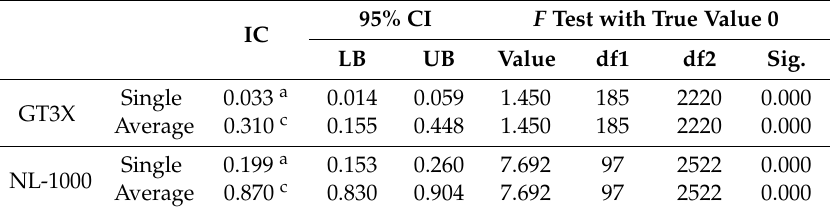
Table 2. Intraclass correlation coefficient (ICC) for accelerometer and pedometer assessments. 95% CI F Test with True Value 0 IC LB UB Value df1 df2